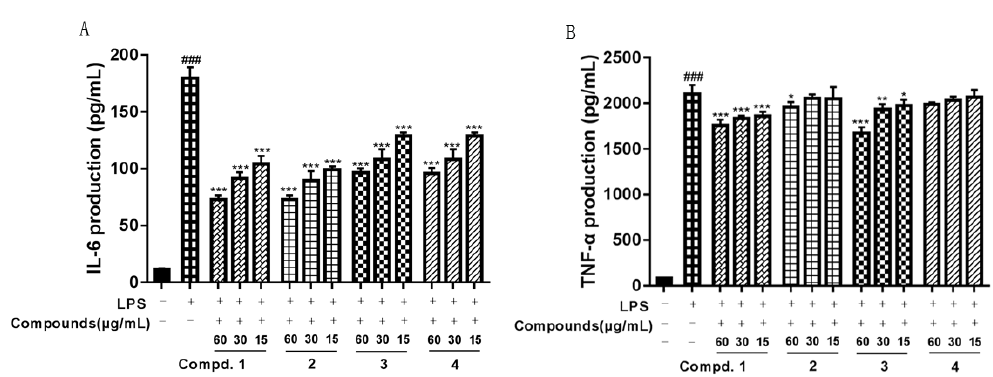
Figure 4. E ff ect of compounds 1 – 4 on production of IL-6 and TNF- α in LPS-stimulated macrophages. Macrophages were stimulated with LPS (100 ng / mL) for 24 h in the absence or presence of compounds 1 – 4 (15, 30 or 60 µ g / mL). Production of IL-6 and TNF- α was assayed in the culture media using an enzyme-linked immunosorbent assay (ELISA) kit ( A , B ). Each value represents the mean ± SEM from three independent experiments. ( ### p < 0.001 versus with control group, * p < 0.05; ** p < 0.01; *** p < 0.001 versus with LPS group).